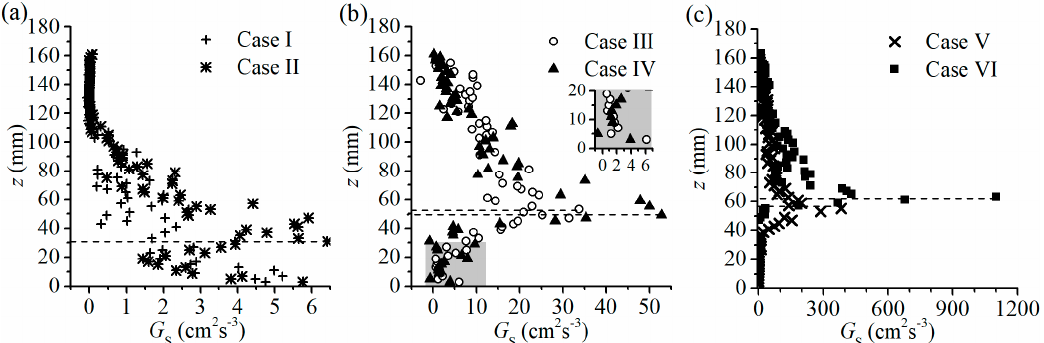
Figure 8. G S profiles with different vegetation densities, in ( a ) Cases I & II, ( b ) Cases III & IV and ( c ) Cases V & VI. Cases V &